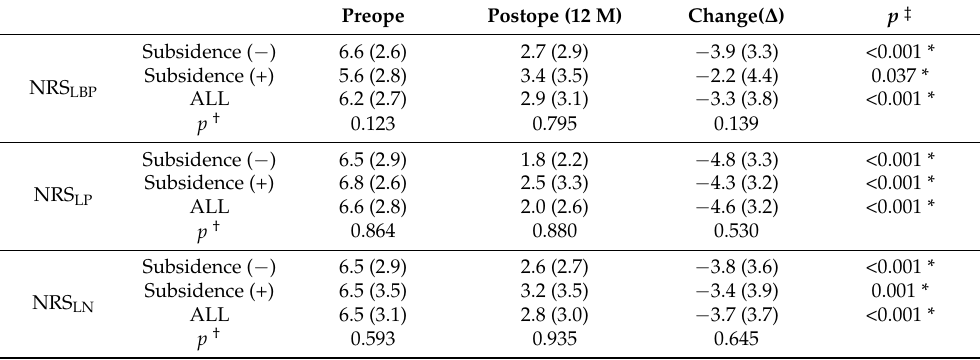
Table 5. Each pain intensity between two groups. NRS LBP , numeric rating scale for low back pain; NRS LP , numeric rating scale for leg pain; NRS LN , numeric rating scale for leg numbness; † comparison between groups, ‡ comparison with pre-op, * statistically significant.